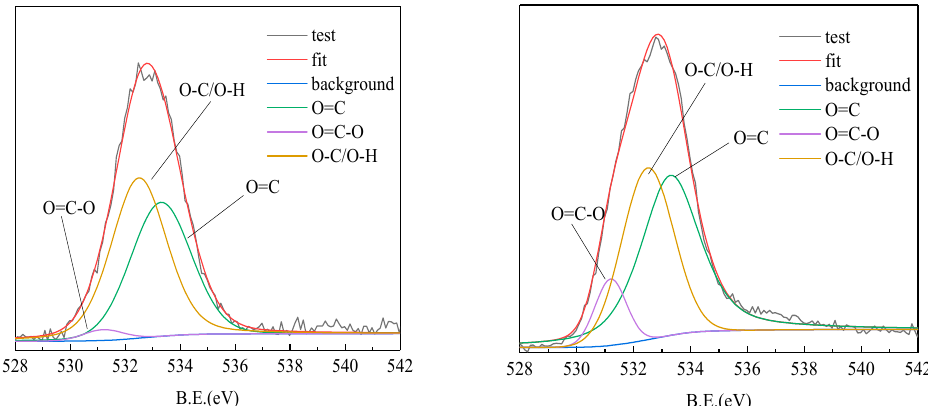
Figure 12 . The XPS fitting spectrum of O(1s) in coking coal before adsorption (left).and coking coal after adsorption ( right after adsorption (right).